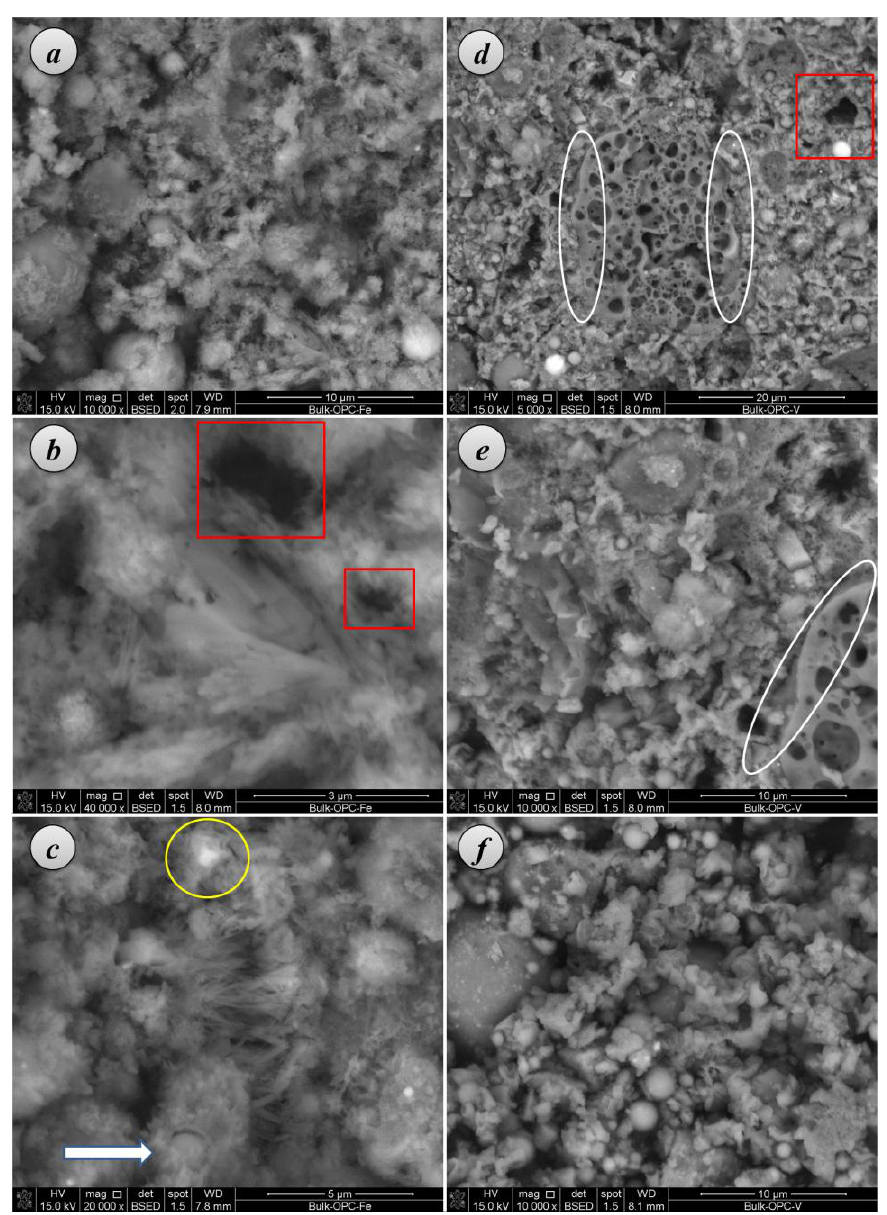
Figure 7. SEM micrographs of PC samples with: 2.5 wt. % of Fe-TiO 2 ( a – c ) and 2.5 wt. % of V-TiO 2 ( d – f ), after 28 curing days.